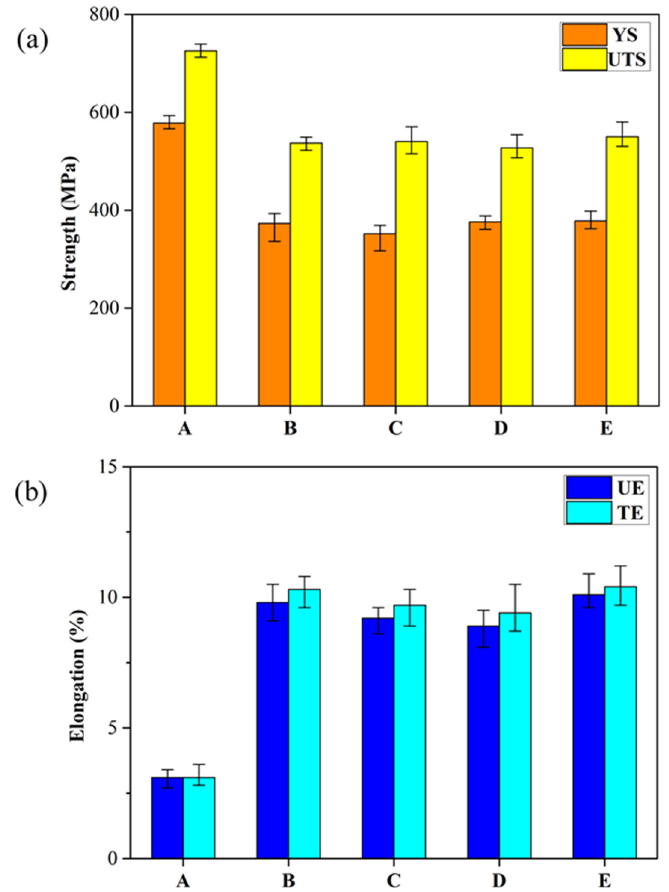
Figure 7. Tensile properties of the Al-Ni-Cu alloy before and after solution treatment: ( a ) strength and ( b ) ductility.